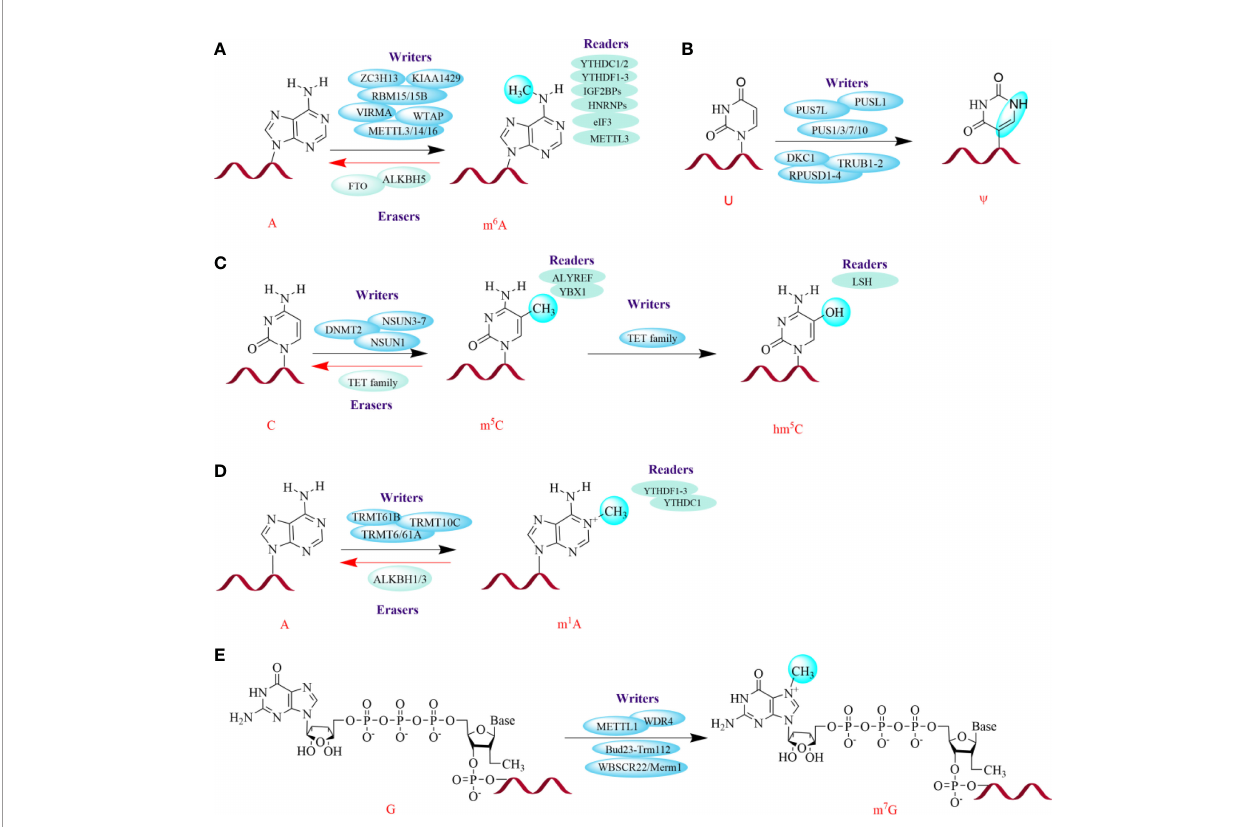
FIGURE 1 | Several major chemical modi fi cations in RNAs. The green spheres on the bases represent modi fi cation sites. The red helices represent RNA. The dynamic and reversible modi fi cations are mediated by three groups of proteins: writers (install modi fi cations on speci fi c sites), erasers (remove modi fi cations), and readers (recognize modi fi cations). METTL3/14/16 , Methyltransferase-like 3, 14, 16; WTAP , Wilms' tumor 1-associating protein; RBM15/15B , RNA-binding motif protein 15/15B; VIRMA , Vir-like m6A methyltransferase associated; ZC3H13 , Zinc fi nger CCCH domain-containing protein 13; FTO , Fat mass and obesity- associated protein; ALKBH5 , ALKB homolog 5; YTHDF1/2/3 , YT521-B homology (YTH) protein families including YTH domain family 1, 2, 3; YTHDC1/2 , YTH domain containing 1, 2; IGF2BPs , Insulin-like growth factor 2 mRNA-binding proteins; HNRNPs , Heterogeneous nuclear ribonucleoproteins; eIF3 , Eukaryotic translation initiation factor; TRMT6/61A , tRNA methyltransferase 6, 61A; PUSs , Pseudouridine synthases; PUS7L , PUS7-like; PUSL1 , PUS-like 1; DKC1 , Dyskerin PUS1; RPUSD1/2/3/4 , RNA PSU domain-covering 1, 2, 3, 4; TRUB1/2 , TruB PSU class member 1, 2; NSUN3-7 , NOL1/NOP2/SUN domain (NSUN) family of proteins 3, 4, 5, 6, 7; DNMT2 , DNA methyltransferase (DNMT) homolog-2; TET family , Ten-eleven translocation family enzymes; ALYREF , Aly/REF export factor; YBX1 , Y box binding protein 1; LSH , lymphoid speci fi c helicase; WBSCR22 , Williams-Beuren syndrome chromosomal region 22 protein, also called BUD23; Merm1 , Metastasis-related methyltransferase 1; WDR4 , WD 159 repeat domain